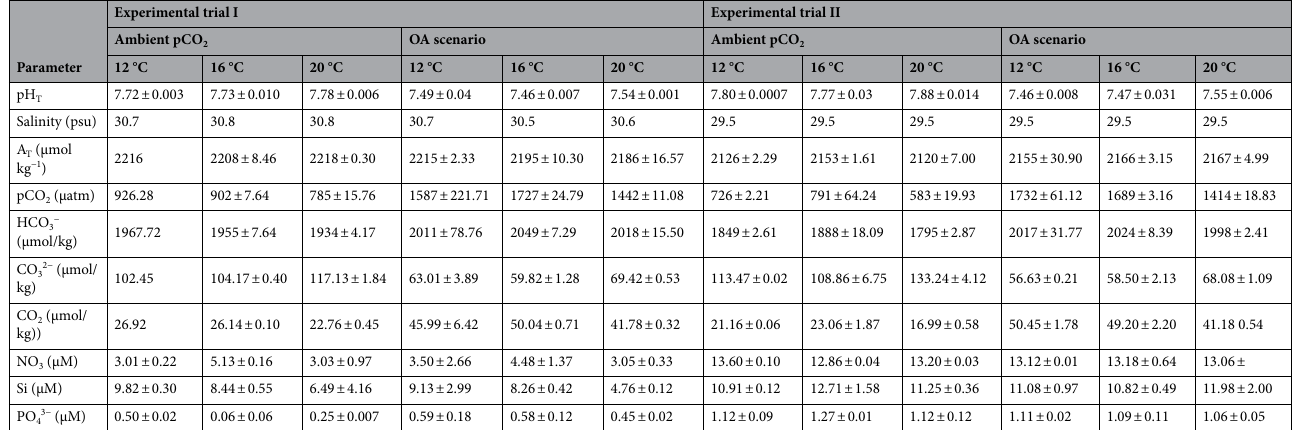
Table 2. Seawater carbonate chemistry parameters (i.e. pH T , A T , pCO 2 , HCO 3− , CO 32− , CO 2 ), salinity and nutrient concentrations (i.e. NO 3− , Si, NH 4+ , PO 43− ) at the start of each experimental trial (I–II). The values represent average (n = 2–3) ±